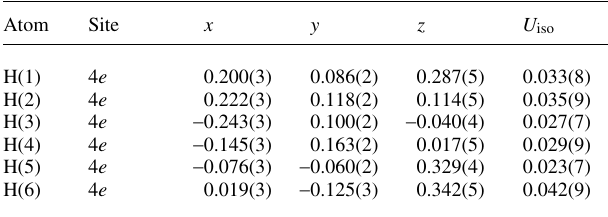
Table 2. Atomic coordinates and displacement parameters (in Å 2 ) . Table 1. Data collection and handling.